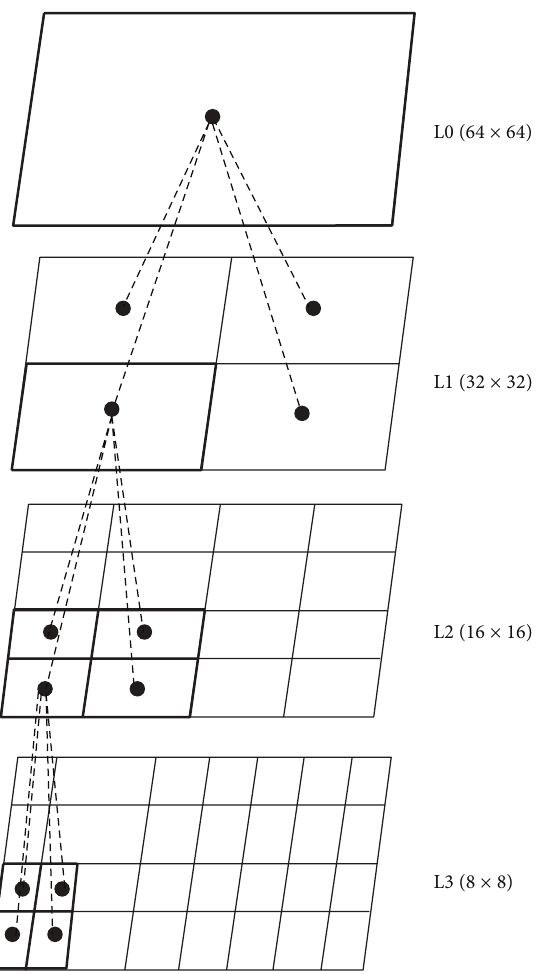
Figure 1: Hierarchical structure of